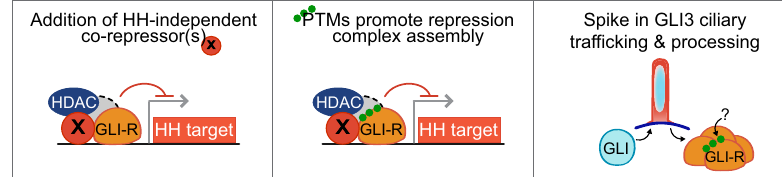
Fig. 6 Model for establishing GLl3 repression. a Model for lack of GLl3 repression prior to HH signaling. In pre-HH limb buds, many target genes are already activated by HH-independent factors. While GLl3 binds to most targets, it is inert as it is unable to regulate deposition of H3K27ac at enhancers or chromatin accessibility. After HH induction when ‘ active ’ GLl3 repression has been established, GLl3 prevents addition of H3K27ac at enhancers to spatially restrict expression of its target genes and pattern the limb. b Schematic of GLl3 spatial regulation of target genes. In pre-HH limb buds, GLl3 does not repress targets such as Hand2 , which is expressed in an expanded anterior domain. In contrast, GLl3 restricts expression of targets to the posterior limb bud where HH signaling is active in post-HH limbs. c Schematic for GLI repression being established in a context-dependent manner. d Possible models for initiating GLl3 repressor activity. Left: HH-independent co-repressor(s), which may not be abundant in early limb development collaborate with GLl3 to assemble a complete repression complex. Middle: Addition of post-translational modi fi cations (PTMs), potentially added via ciliary traf fi cking and processing, promote assembly of, or stabilize, a GLI repression complex. Right: A spike in ciliary GLl3 processing, as re fl ected by increased axonemal colocalization, increases the amount of viable GLl3 repressor, potentially through addition of PTMs as suggested